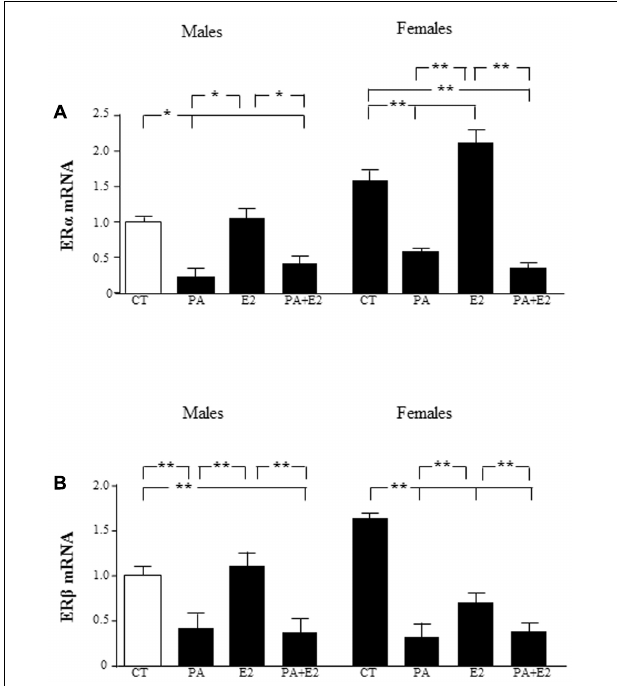
FIGURE 3 | Effects of PA and 17 β estradiol (E2) on estrogen receptor α (ER α ) and estrogen receptor β (ER β ) mRNA levels. Astrocyte cultures were treated with PA (0.5 mM), E2 (10 − 10 M) or the combination of both. Relative mRNA levels of ER α in cultures from males and females (A) ; and ER β in cultures from males and females (B) were measured. The average of three independent assays performed in duplicate is shown. Statistical significance: ∗ p < 0.05 and ∗∗ p <